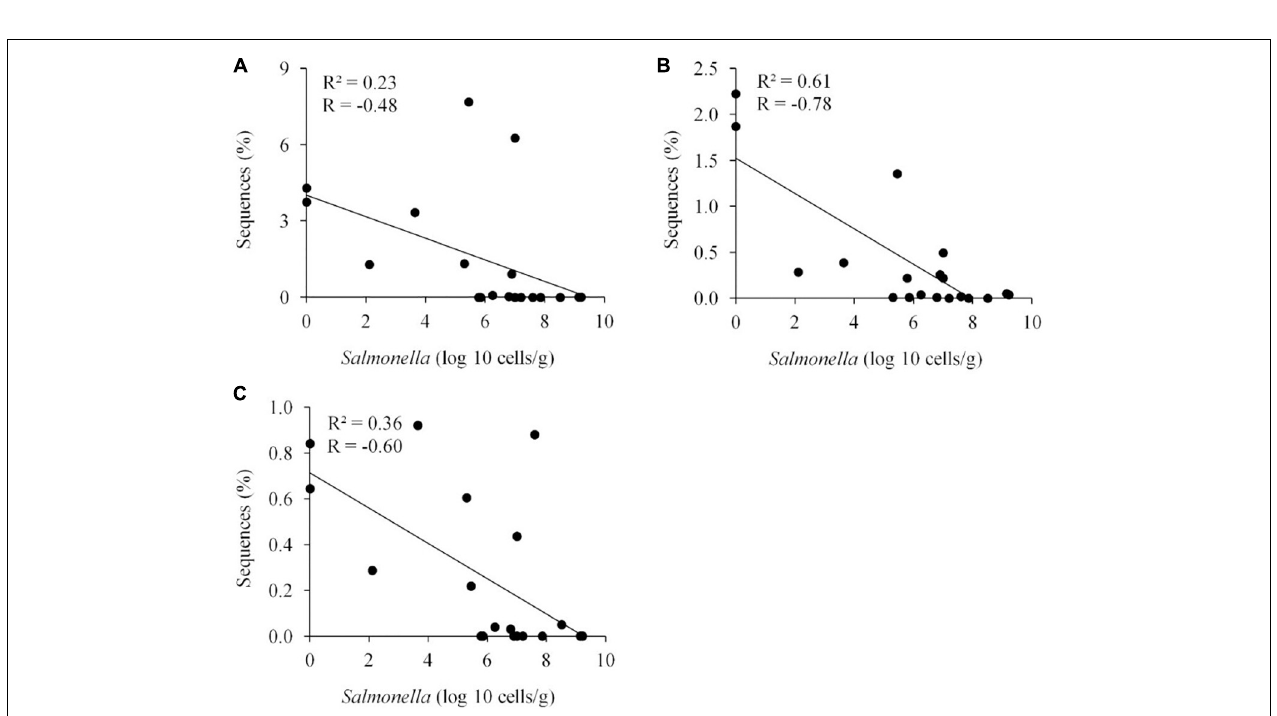
FIGURE 7 | Negative correlation between the presence of specific OTUs and Salmonella abundance in the ceca ( n = 19). Faecalibacterium prausnitzii OTU 10, 98%, P < 0.05 (A) ; Oscillibacter ruminantium OTU 28, 95%, P < 0.001 (B) ; and Ethanoligenens harbinense OTU 31, 95%, P < 0.01 (C) . R , Pearson correlation coefficient; and R 2 , coefficient of